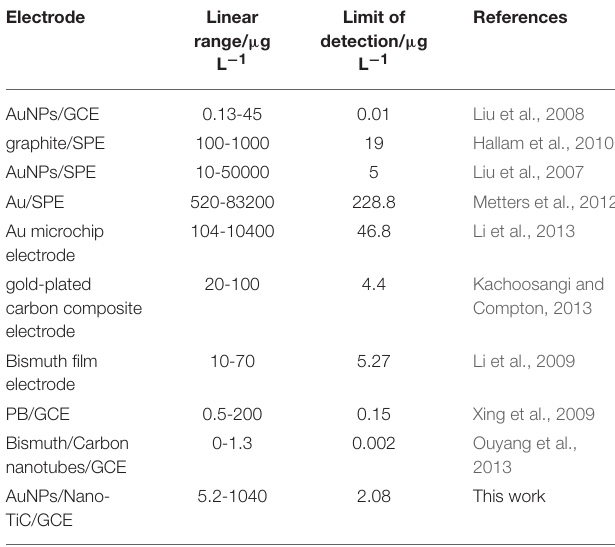
TABLE 2 | Comparison of the performances of different modified electrodes for the determination of